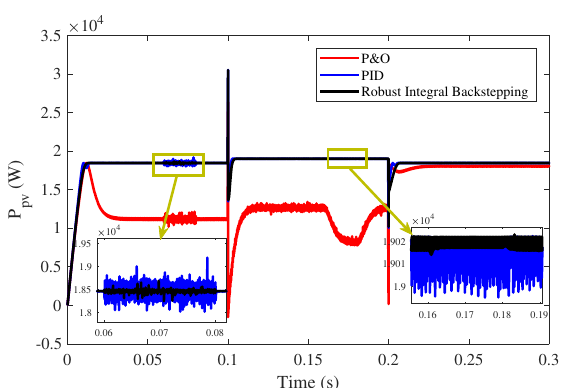
Figure 28. Output power of PV array with multiple uncertainties under varying temperature and